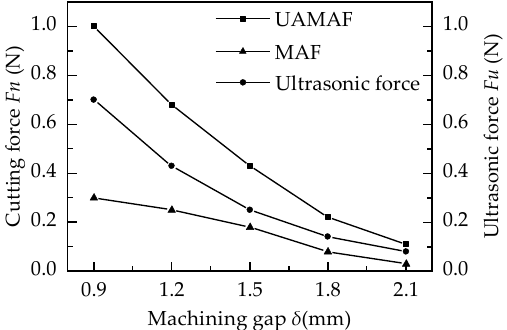
Figure 8. The relationship between machining gap and cutting force.